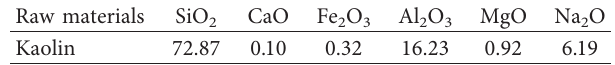
Table 1: Chemical composition of raw